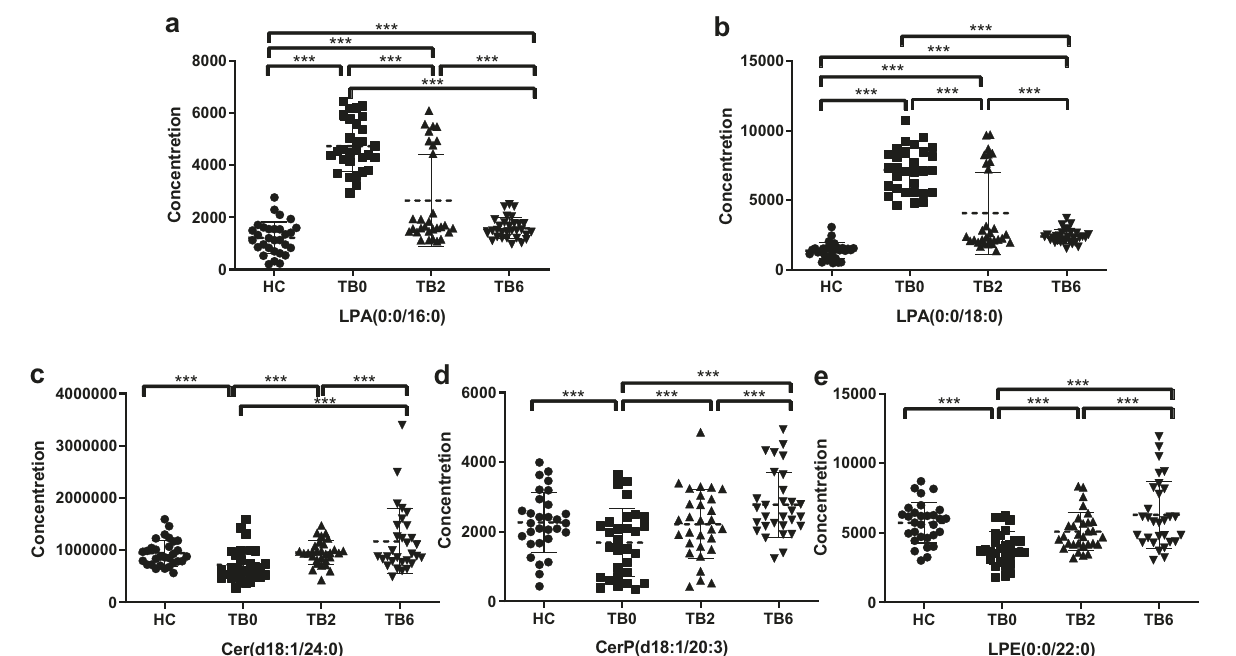
Fig. 5 The changes of differential lipids in HC, TB0, TB2, and TB6 groups. a Relative concentration of LPA (0:0/16:0) in HC, TB0, TB2, and TB6 groups. b Relative concentration of LPA (0:0/18:0) in HC, TB0, TB2, and TB6 groups. c Relative concentration of Cer (d18:1/24:0) in HC, TB0, TB2, and TB6 groups. d Relative concentration of CerP (d18:1) in HC, TB0, TB2, and TB6 groups. e Relative concentration of LPE(0:0/22:0) in HC, TB0, TB2, and TB6 groups. Mann – Whitney U test was used to test the statistical signi fi cance. *** P < 0.001